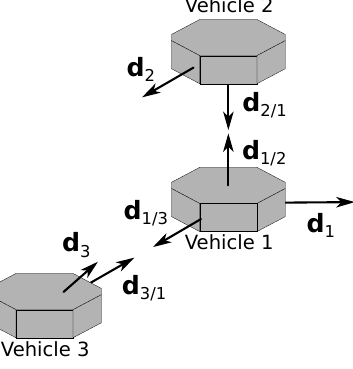
Figure 5. Initial configuration for the